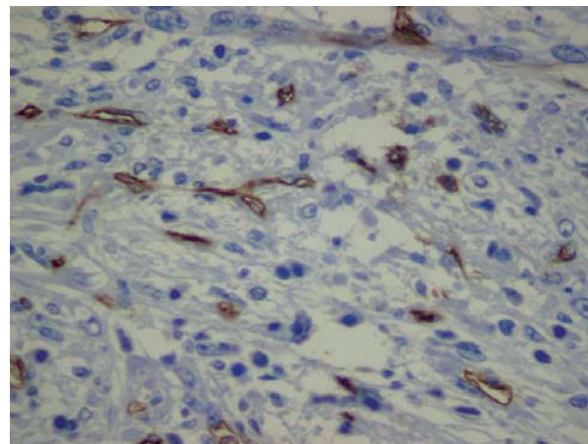
Fig. 5 – Marcação imunohistoquímica para CD34, mostrando